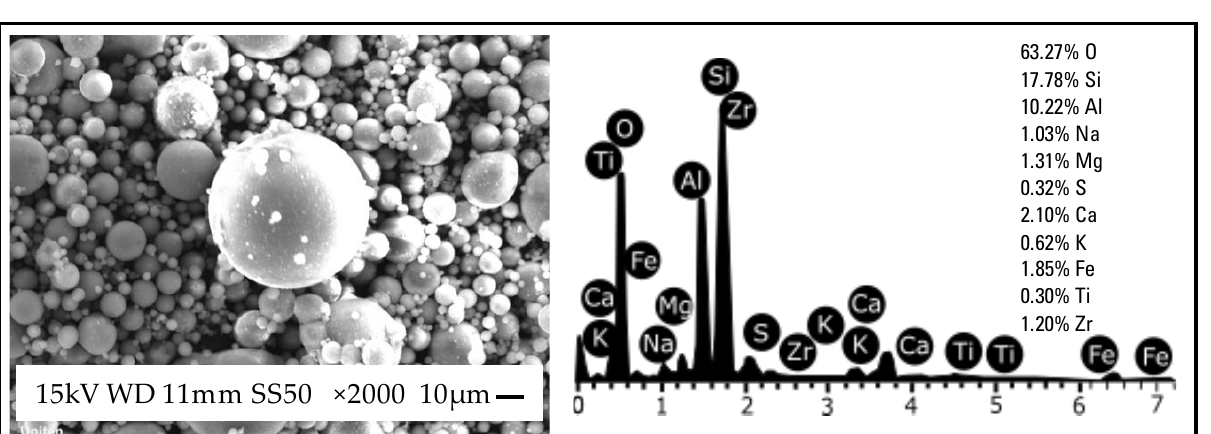
Table 4. Mix design of the fly ash – rPET waste composite material.